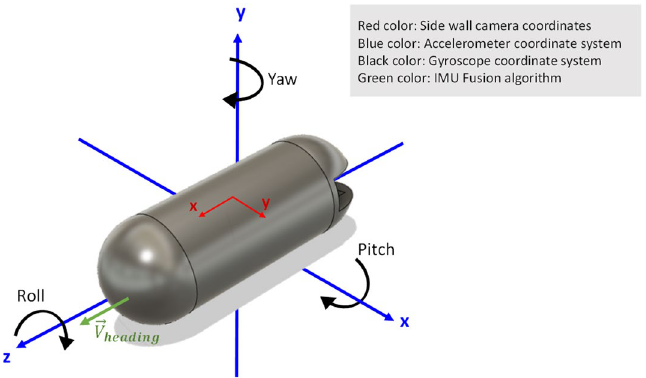
Figure 5. Rotation about different